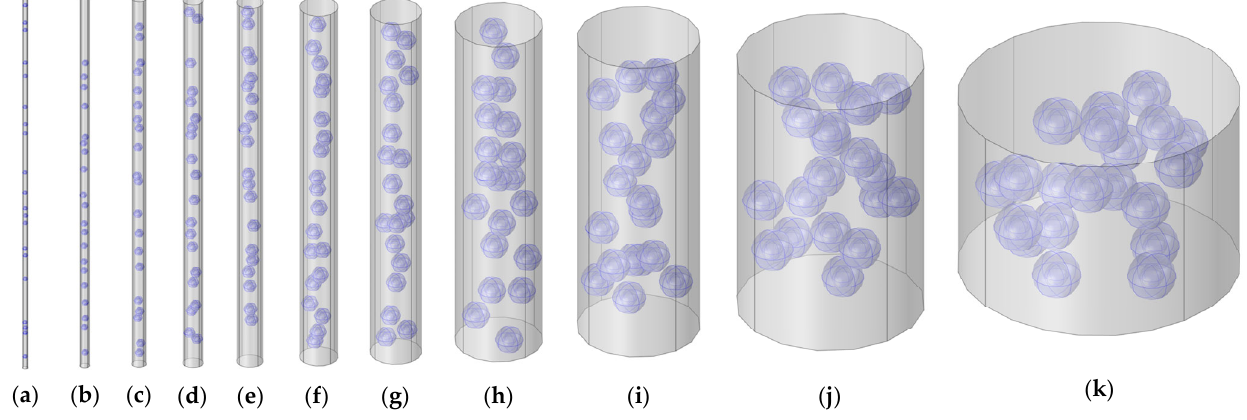
Figure 6. Acoustic finite element simulation models of the composite rubber reinforced with HGM for the various diameter of the HGM. ( a ) 20; ( b ) 30; ( c ) 40; ( d ) 50; ( e ) 60; ( f ) 80; ( g ) 100; ( h ) 150; ( i ) 200; ( j ) 300; ( k ) 500. Table 3. The summarized STL data with the various diameter of the